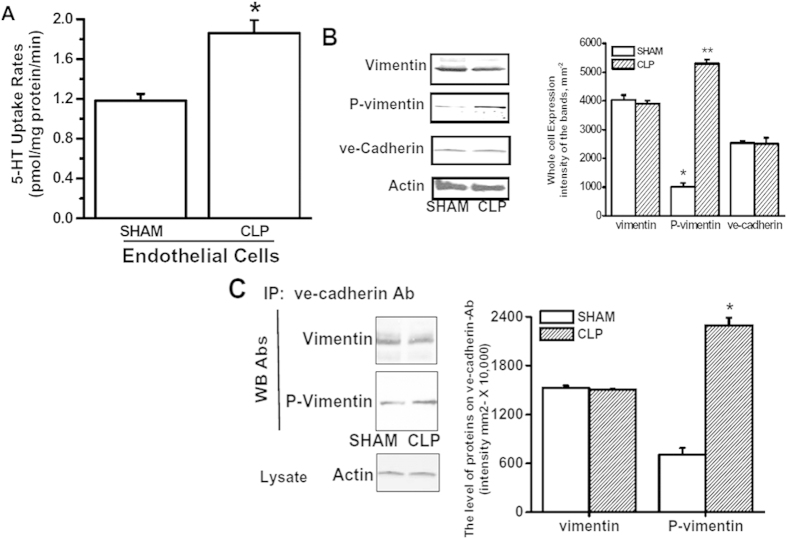
Endothelial cells incubated in CLP serum.(A) 5-HT uptake rates. Elevated plasma 5-HT was associated with a 1.57-fold higher 5-HT uptake rates of endothelial cells (2 × 105 cells/assay) cultured in CLP compared to the ones incubated in SHAM serum. All assays were performed in triplicate. The rate of uptake is expressed as the mean ± SD of triplicate determinations from three independent experiments. *P < 0.001(compared with cells cultured in CLP versus SHAM serum samples, respectively). (B) WB analysis of endothelial cells cultured in CLP or SHAM serum for P-vimentin and ve-cadherin. The endogenous expressions of vimentin, P-vimentin and ve-cadherin were identified with WB analysis of endothelial cells (2 × 105 cells/assay) cultured in SHAM or CLP serum. No significant differences were detected in the total expression of vimentin and ve-cadherin between in endothelial cells treated with SHAM or CLP serum. (C) co-IP for endothelial cells cultured in CLP vs SHAM serum. Endothelial cells cultured in serum prepared from the blood samples of SHAM (S) or CLP mice. Next day the cell lysates were incubated with ve-cadherin monoclonal Ab coated protein A sepharose beads. The immunoprecipitates were subjected to WB analysis with vimentin or P-vimentin polyclonal Abs. The level of P-vimentin on ve-cadherin Ab was found elevated in cells cultured in CLP serum; however, no differences were found in the level of vimentin.